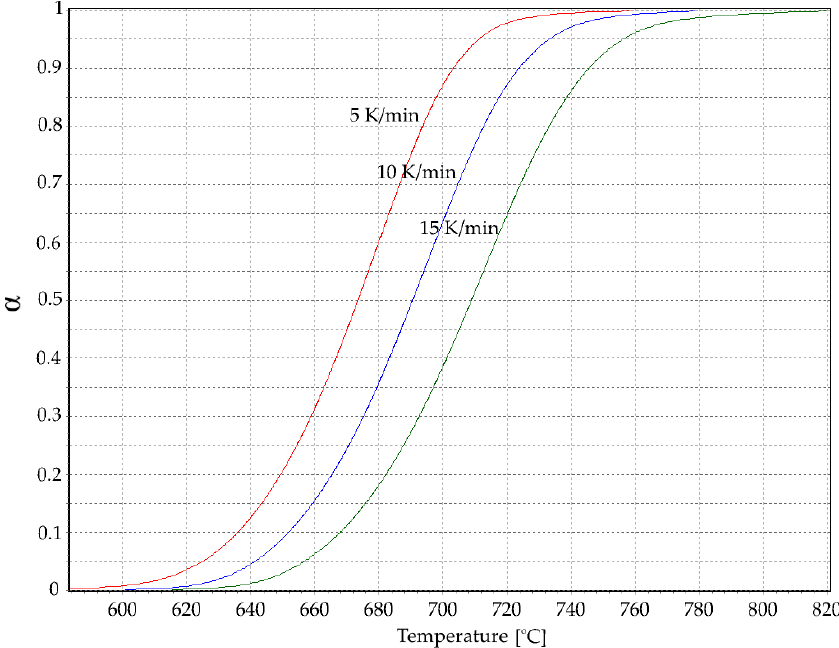
Figure 2. Degree of transformation α as a function of temperature at different heating rates. The reaction rate as a function of the temperature at di ff erent heating rates was calculated using formula (3) and shown in Figure 3.